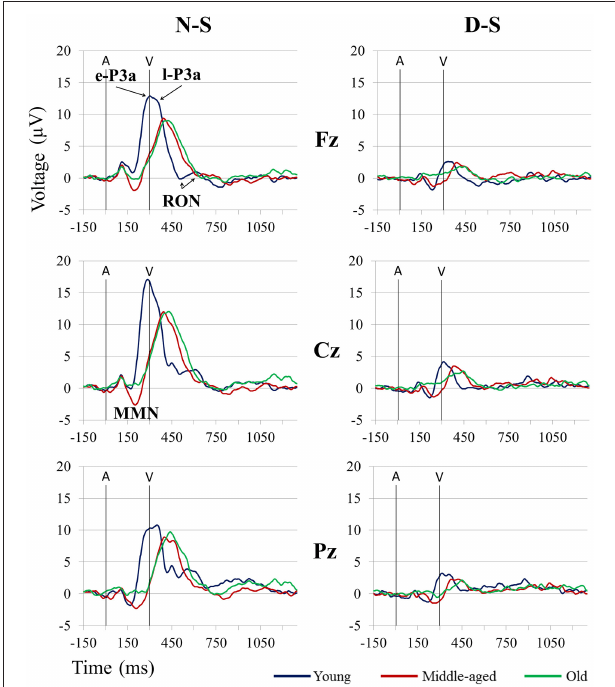
FIGURE 3 | Grand-average event-related potential waveforms at Fz, Cz, and Pz, in the novel minus standard (N-S, left) and deviant minus standard (D-S, right) difference waveforms, for the three age groups (Young, Middle-aged, and Old). A, Auditory stimulus; V, Visual stimulus. Digital bandpass filter: